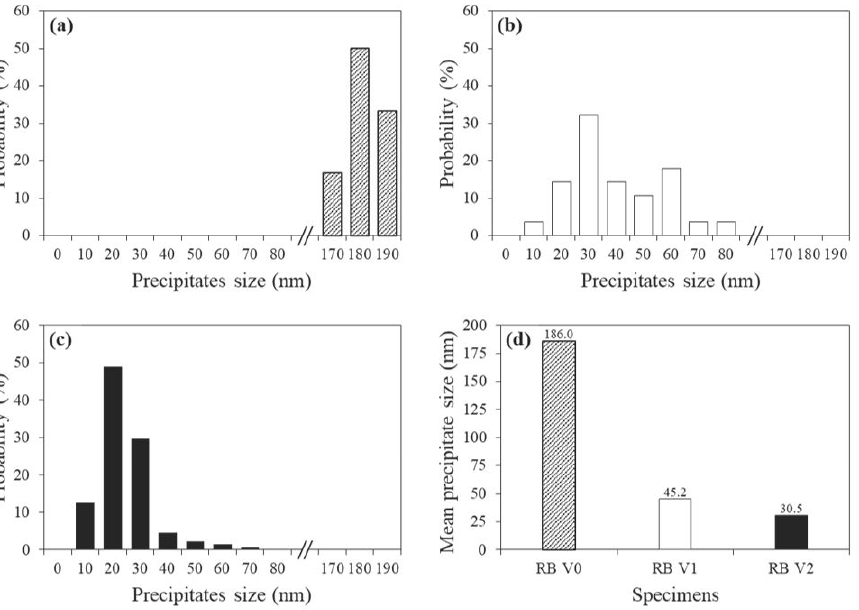
Figure 6. Behaviour of precipitates for various V contents; ( a ) RB V0, ( b )RB V1, ( c ) RB V2 and ( d ) the average size of precipitates for various